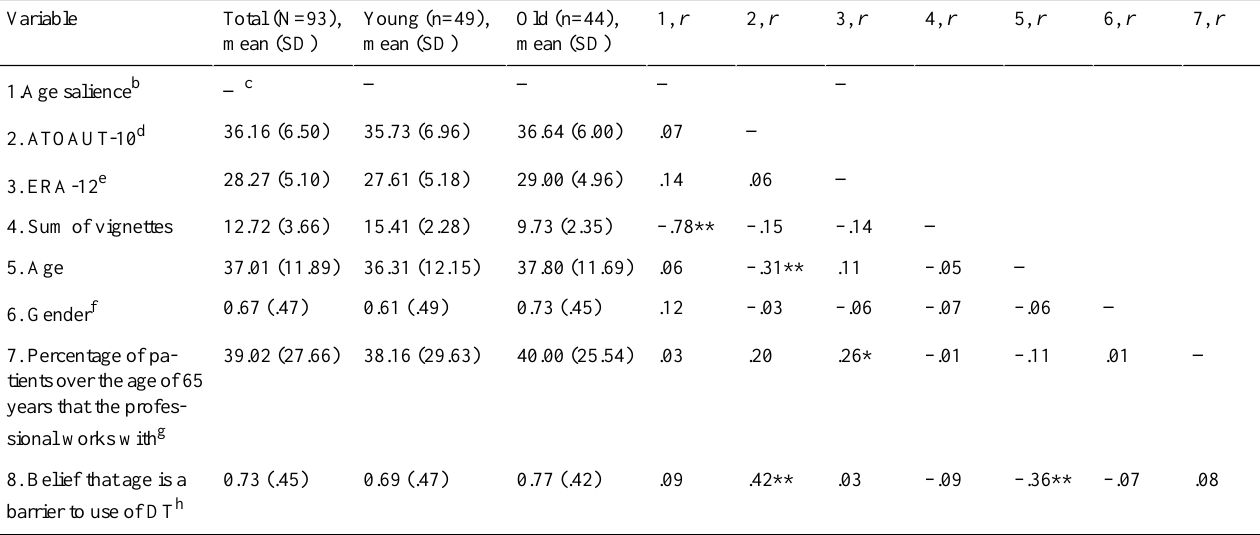
Table 3. Means and SDs by age salience (young and old) and correlations (N=93) a